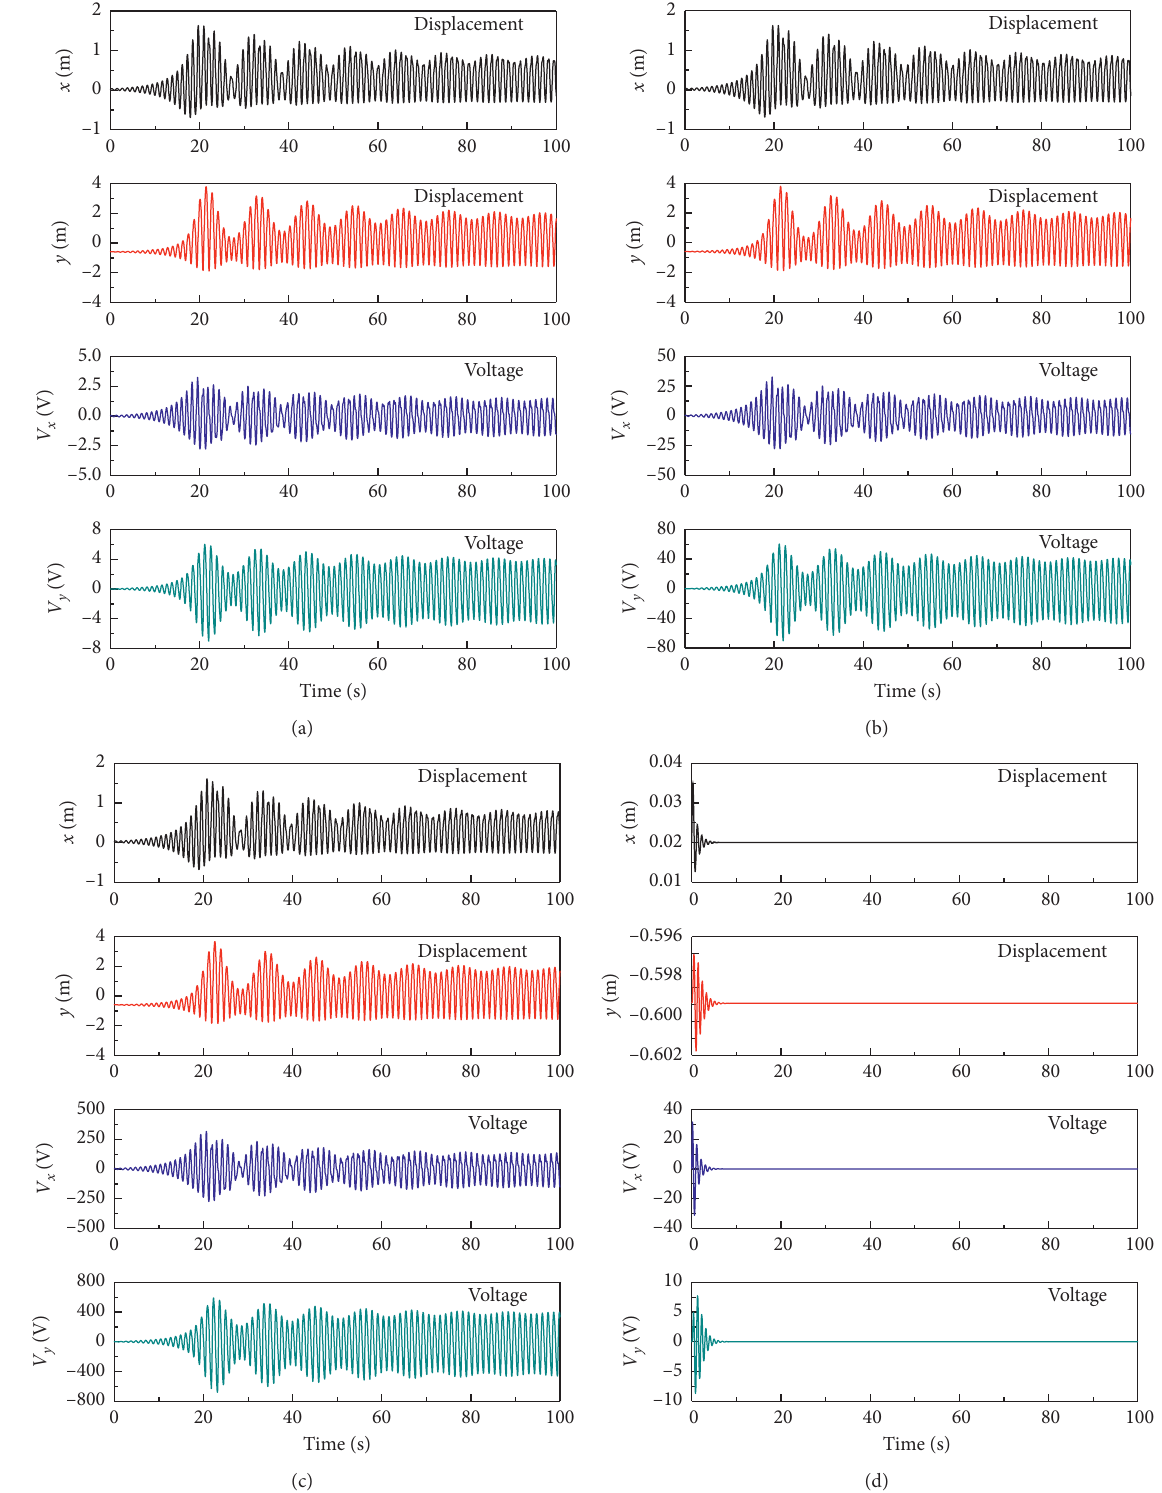
Figure 30: Considering separation, the displacements and output voltages of the friction system when the force factor of piezoelectric elements is α � 3.1 × 10 − 5 N/V (a), α � 3.1 × 10 − 4 N/V (b), α � 3.1 × 10 − 3 N/V (c), and α � 3.1 × 10 − 2 N/V